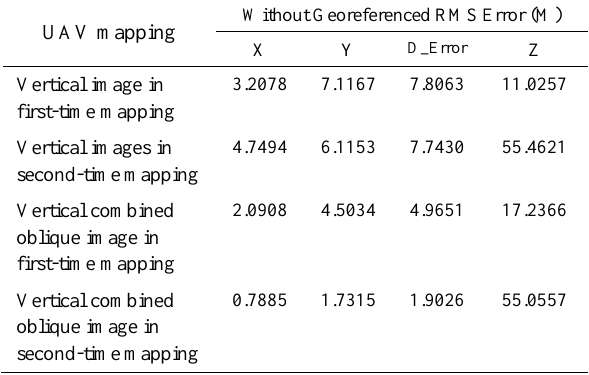
Table 7. Showing the root mean square error X, Y, Z and distant error of no georeferenced